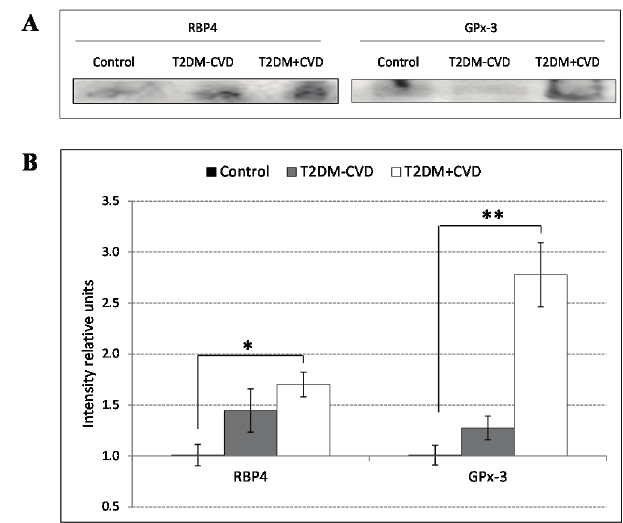
Figure 1. Sypro stained representative 2D-DIGE map of the depleted serum showing the pick location of the proteins differentially expressed. The protein spots found significantly increased ( p < 0.05) in T2DM + CVD patients compared to the others groups are marked with red arrows; The protein spot found significantly decreased ( p < 0.05) in T2DM + CVD patients compared to the others groups are marked with blue arrow; The protein spots found significantly decreased in T2DM patients ( p < 0.05) in regard to the control group are marked with black arrows.